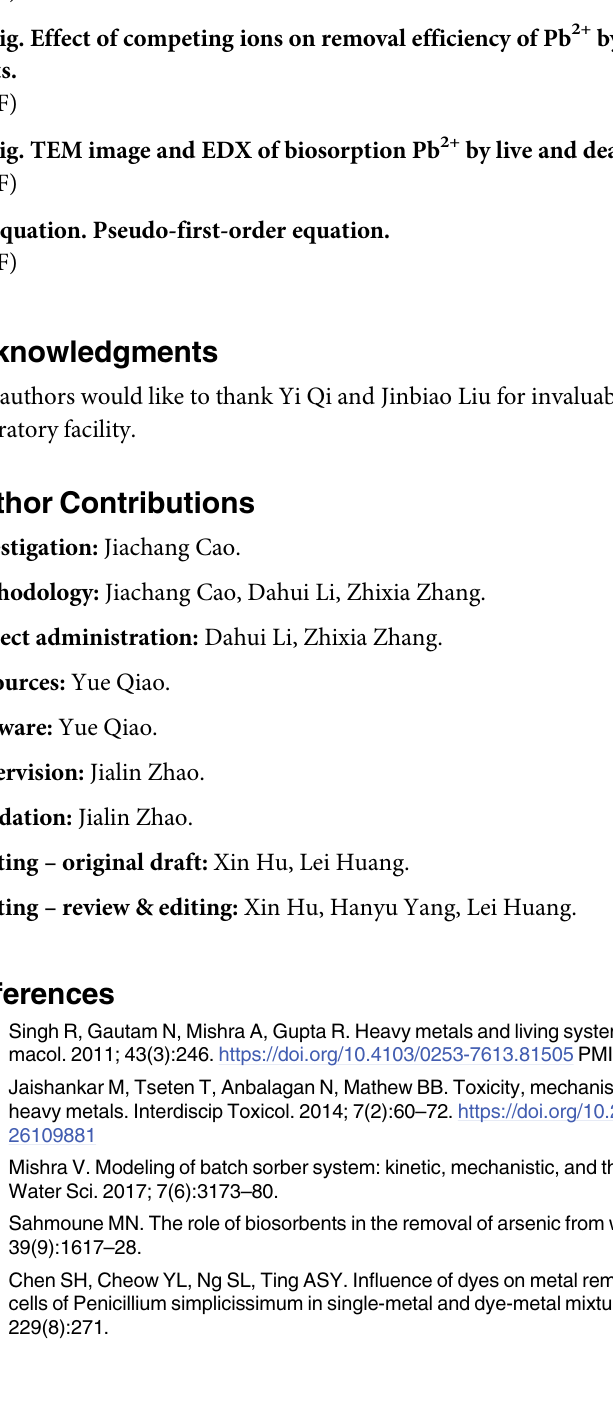
S3 Fig. Langmuir adsorption isotherms for Pb 2+ using live (a) and dead biosorbents (b). (PDF) S4 Fig. Freundlich adsorption isotherms for Pb 2+ using live (a) and dead biosorbents (b). (PDF) S5 Fig. Effect of pH on desorption efficiency of Pb 2+ from live and dead biosorbents (a) and the recycling experiments (b). (PDF) S6 Fig. Effect of competing ions on removal efficiency of Pb 2+ by the live and dead biosor- bents. (PDF) S7 Fig. TEM image and EDX of biosorption Pb 2+ by live and dead biosorbents. (PDF) S1 Equation. Pseudo-first-order equation.